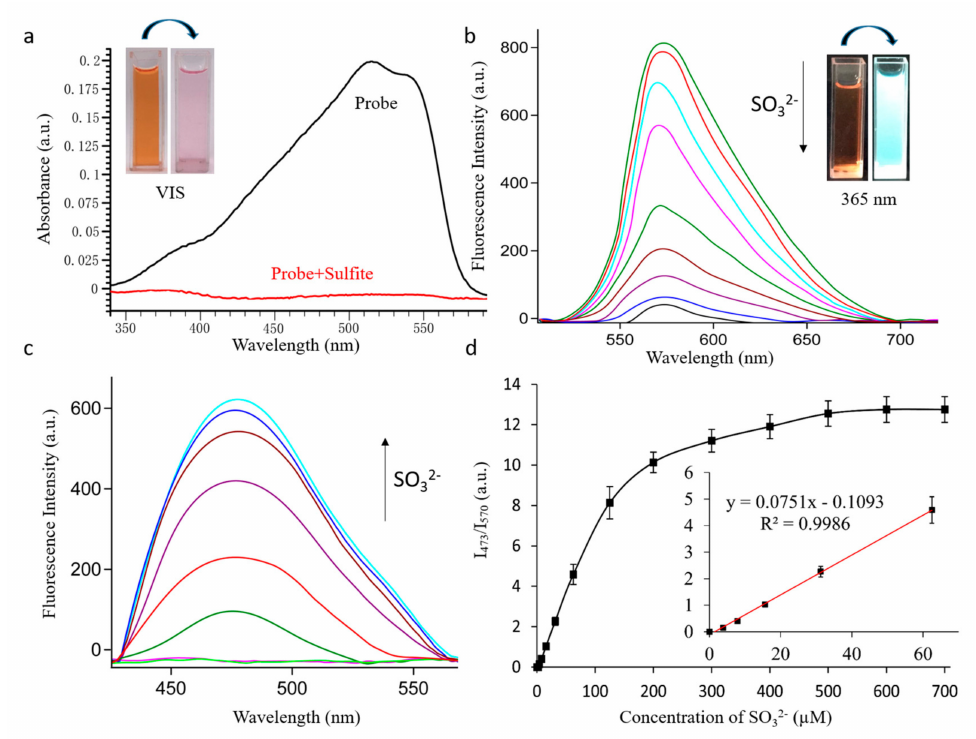
Figure 1. ( a ) UV-Vis absorption spectra changes and ( b – c ) fluorescence spectra changes of the probe EB (10 µ M) in PBS solution (pH 7.4) with increasing amount of SO 32 − (0–500 µ M). For ( b ) λ ex = 485 nm slits: 10.0 / 10.0 nm; for ( c ) λ ex = 380 nm slits: 5.0 / 5.0 nm. ( d ) Linear correlation between the emission intensity ratio (I 473 / I 570 ) and the concentration of SO 3 2 −